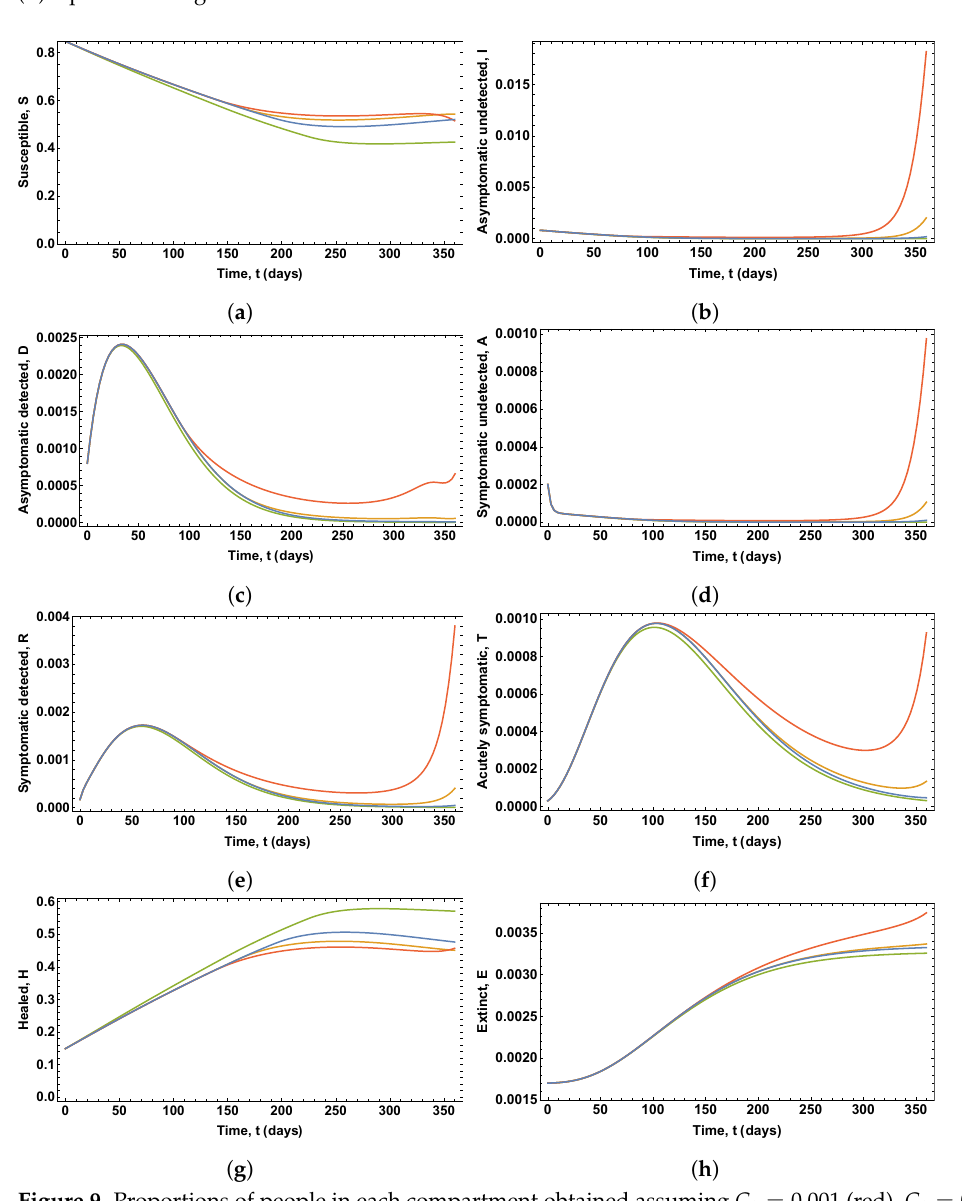
Figure 9. Proportions of people in each compartment obtained assuming C 1 = 0.001 (red), C 1 = 0.01 (orange), C 1 = 0.1 (blue), and C 1 = 1 (green), while fixing parameters C 2 = 0.1 and C 3 = 0.0001: ( a ) Susceptible people. ( b ) Asymptomatic undetected people. ( c ) Asymptomatic detected people. ( d ) Symptomatic undetected people. ( e ) Symptomatic detected people. ( f ) Acutely symptomatic people. ( g ) Healed people. ( h ) Extinct